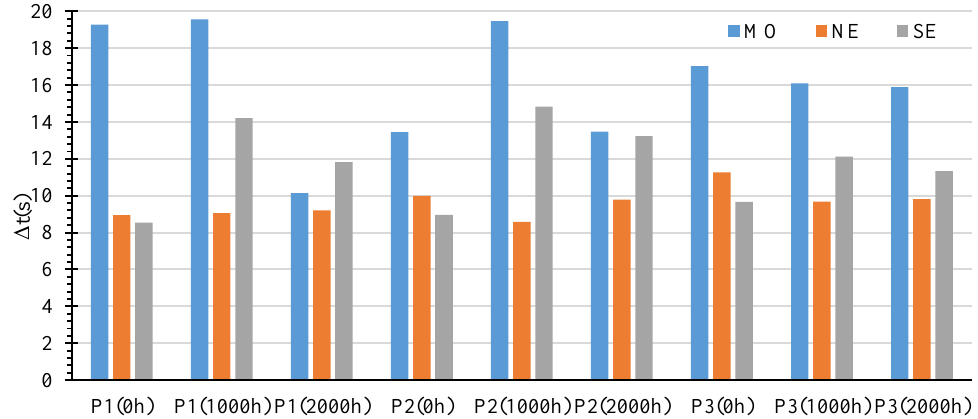
Figure 3. Delay time as a function of the electrode tip and aging time.